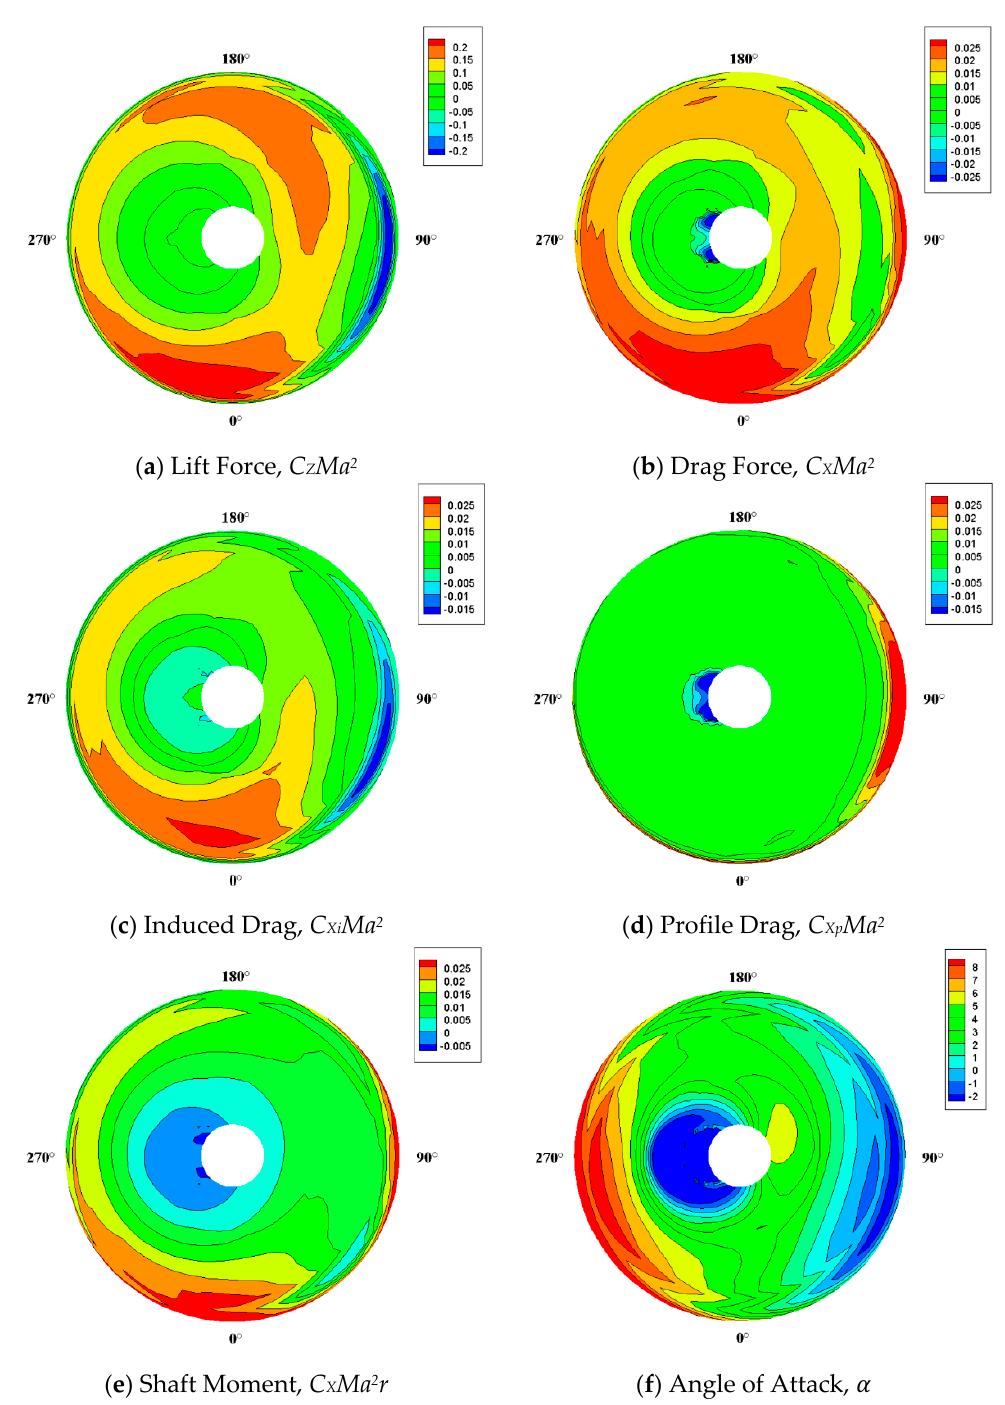
Figure 11. Dimensionless rotor aerodynamic load distribution of the baseline rotor for condition B. For condition B, the rotor power reductions relative to the baseline rotor that are ob- tained with 1~3/rev harmonic inputs are 2.08%, 4.01% and 1.09%, respectively. The opti- mal amplitudes are 0.9°/m, 0.4°/m, and 0.2°/m. The optimal phase angles of the 1~3/rev harmonic inputs are 330°, 225°, and 90°, as shown in Figure 12. The optimal schedules are shown in Figure 13. Generally, the increase in rotor power reduction begins to level off with the amplitude beyond 1.0°/m for the 1/rev uniform twist control, while the optimal amplitude for the 0/rev and 2~5/rev control is smaller. Therefore, the saturation limit of the amplitude for active control is set as 1.0°/m in the subsequent analysis and optimiza- tion work.